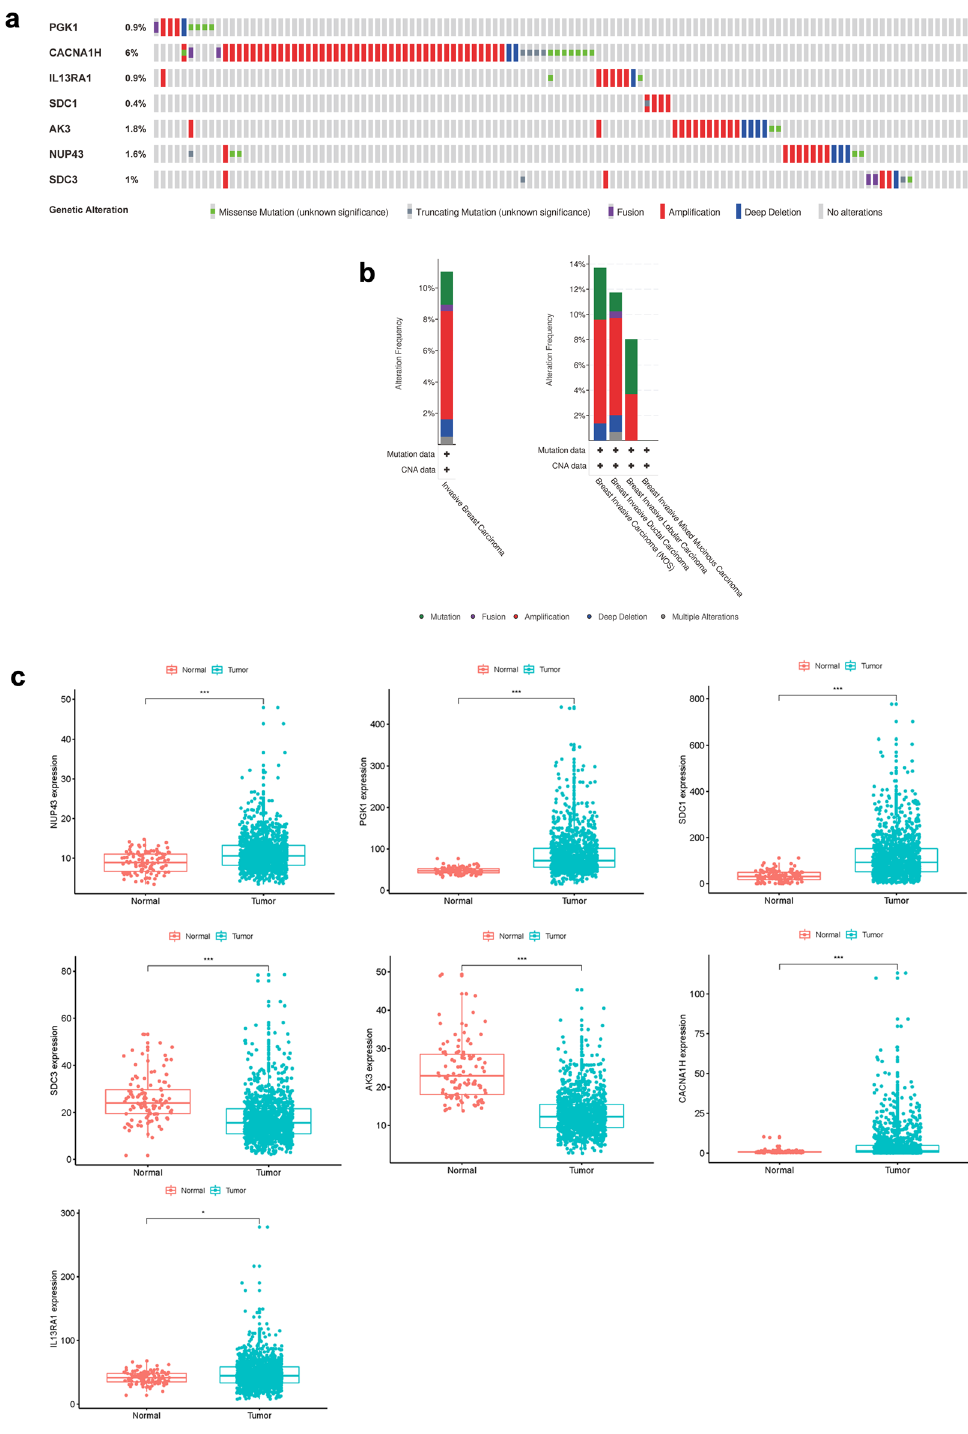
Figure 2. Identification of patient survival mRNAs. ( a ) Alteration of the selected genes in clinical samples. ( b ) Modification of chosen genes in various pathological forms of BC. ( c ) Multiple expression of seven genes